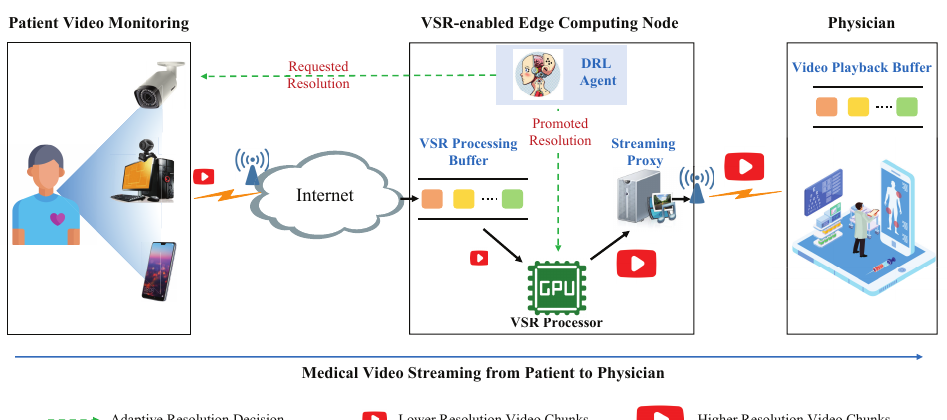
Figure 1. The reference architecture of VSR-enabled telemedicine systems—SR-Telemedicine, which mainly consists of three parts: patient video monitoring, VSR-enabled edge computing, and physician video